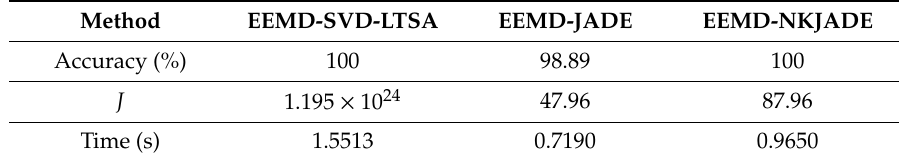
Table 3. Results from dataset